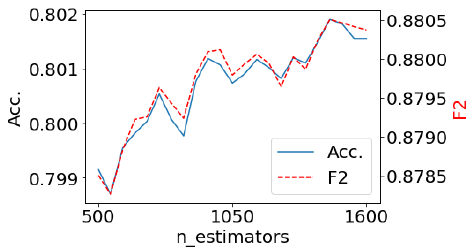
Figure 7. Effect of the number of decision trees on random forest performance.